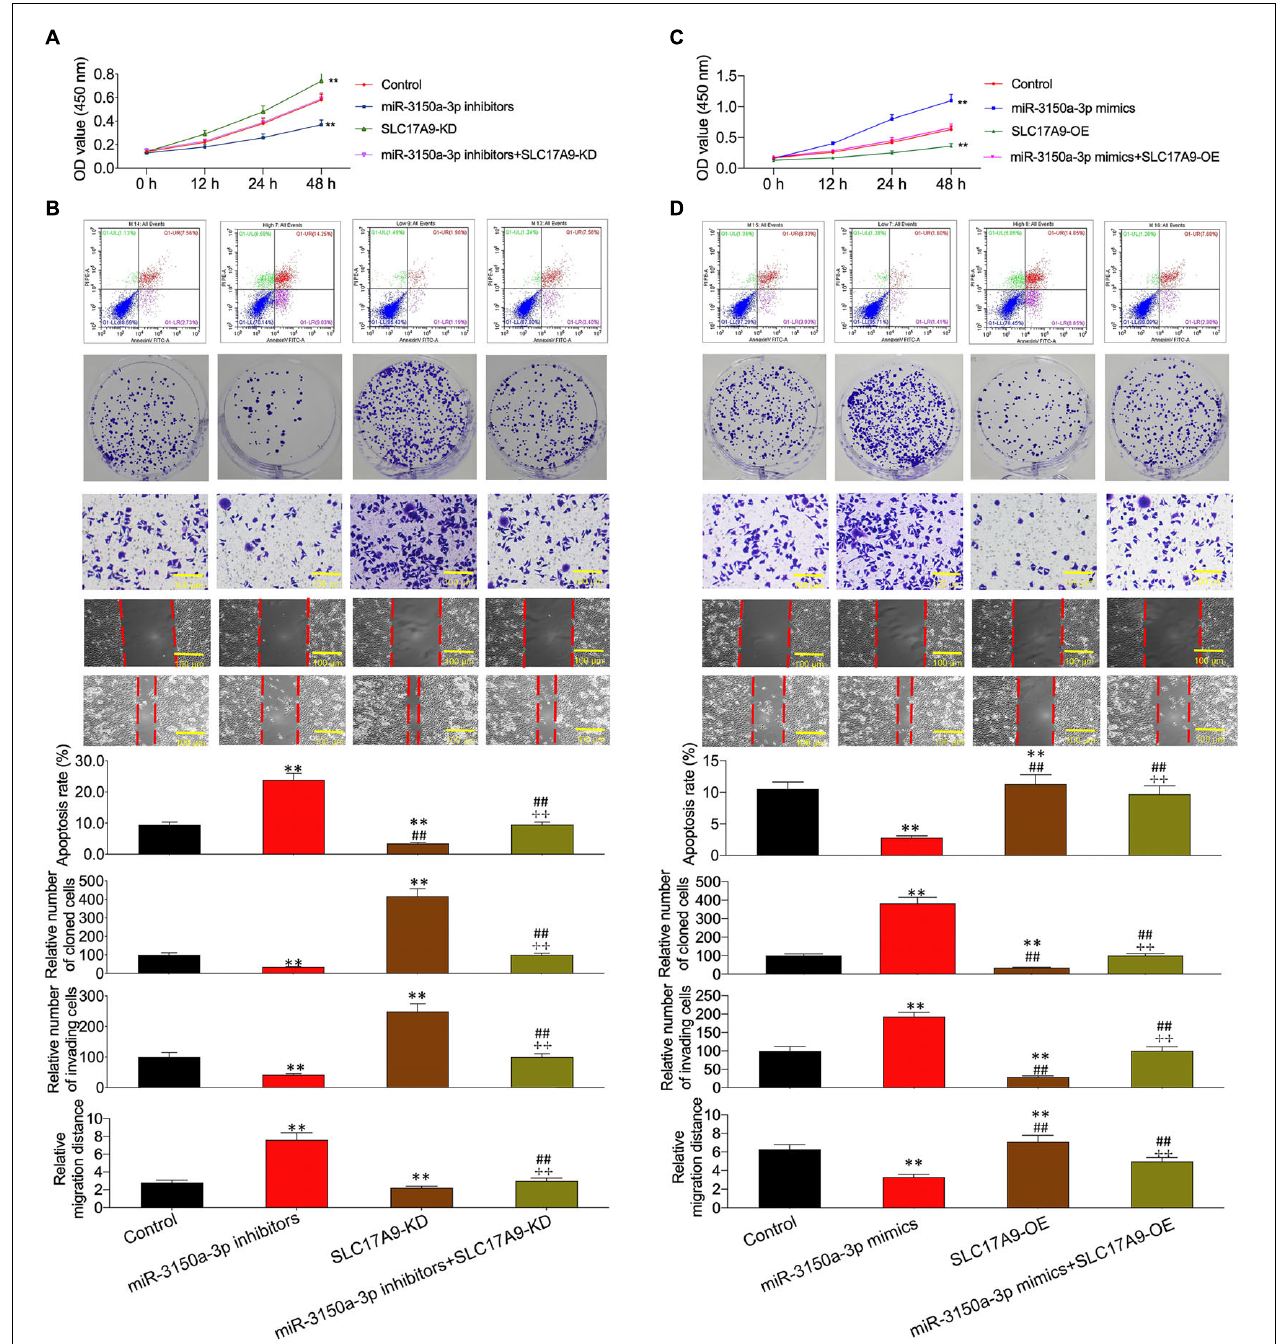
FIGURE 9 | miR-3150a-3p regulated cell proliferation, apoptosis, migration, and invasion via targeting SLC17A9 in vitro. Cell viability (A,C) , cell apoptosis, proliferation, invasion, and migration (B,D) of cells co-transfected with miR-3150a-3p inhibitors and siRNA-SLC17A9 or miR-3150a-3p mimics and SLC17A9-expressing vector determined by CCK-8, flow cytometry, colony formation, Transwell, and scratch assays. Each independent assay was conducted in triplicate; ** vs. control group, p < 0.01.